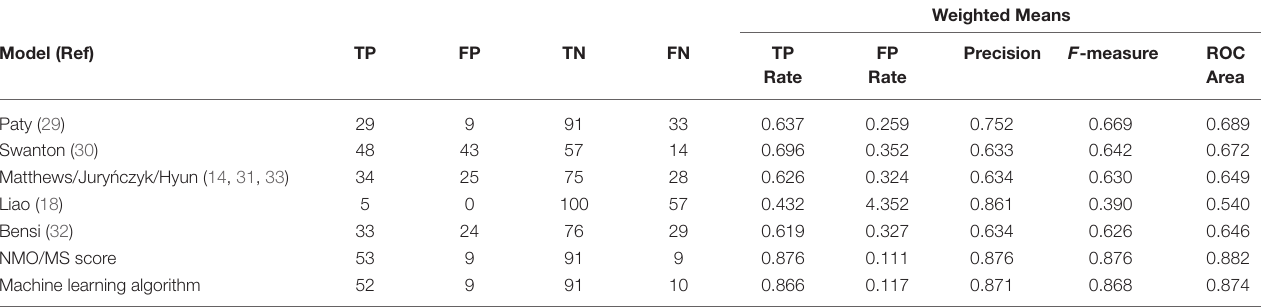
TABLE 4 | Summary of predictive models for NMOSD and multiple sclerosis based on MRI.